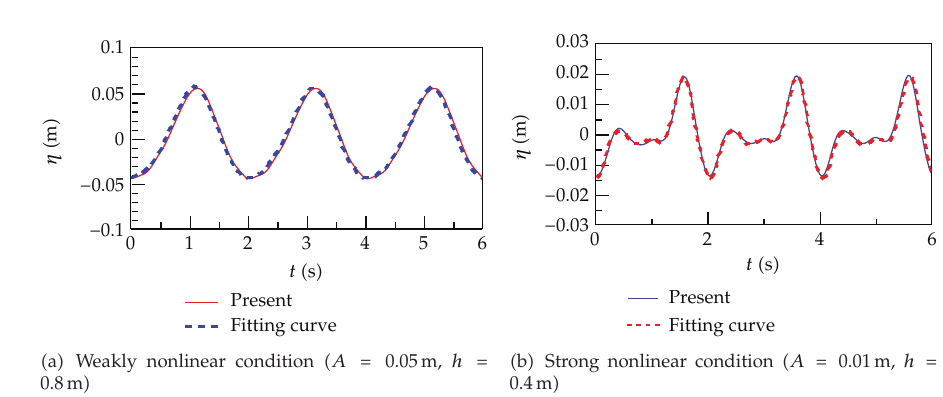
Figure 5: Comparison of free surface at x (cid:9) 25 . 75m between the numerical solution and the fitting curve.